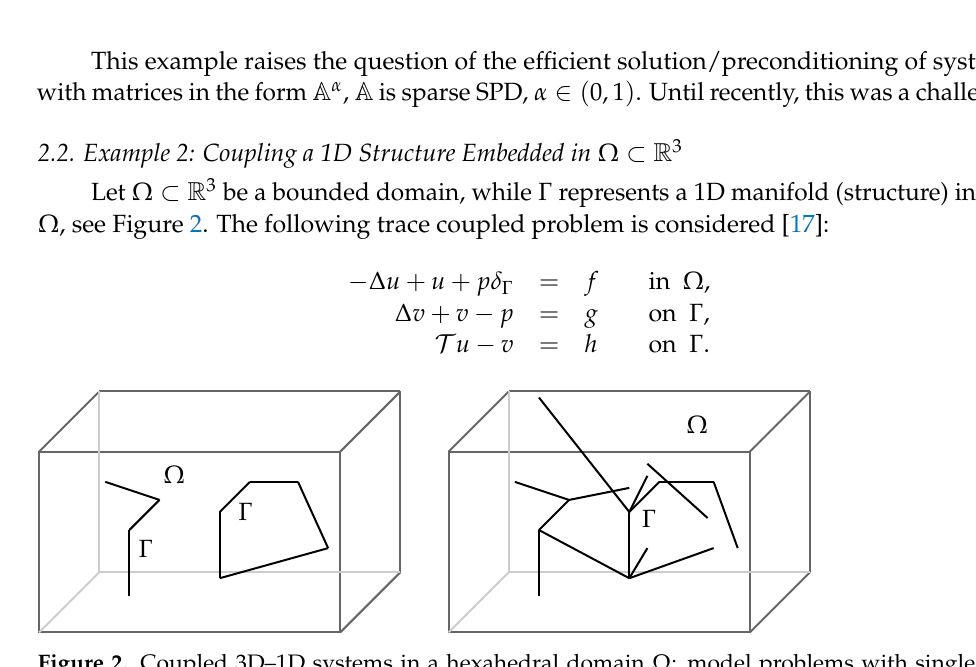
Figure 2. Coupled 3D–1D systems in a hexahedral domain Ω : model problems with single line geometry of the interfaces ( left ) and more realistic problem with more general geometry of the interface ( right